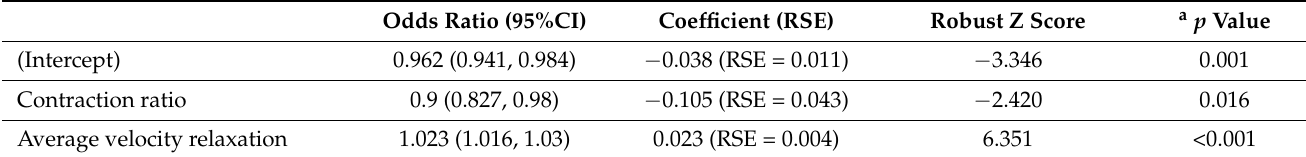
Table 3. Final model.